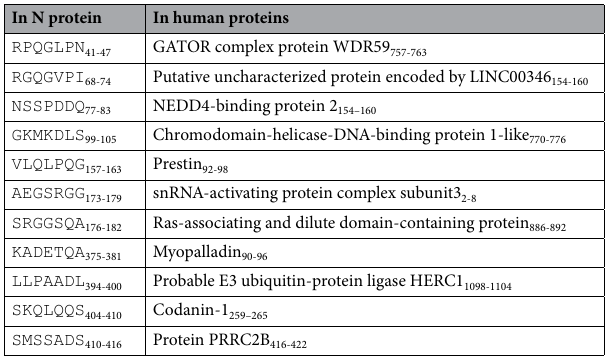
Table 5. Localization of homologous 7-mers in the N protein and human proteins.